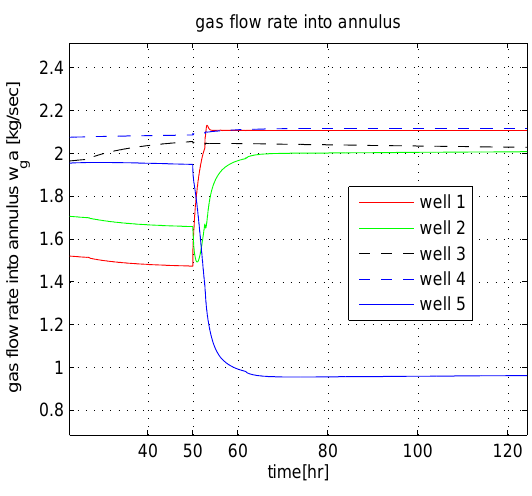
Figure 8: Lift gas distribution among wells with optimization